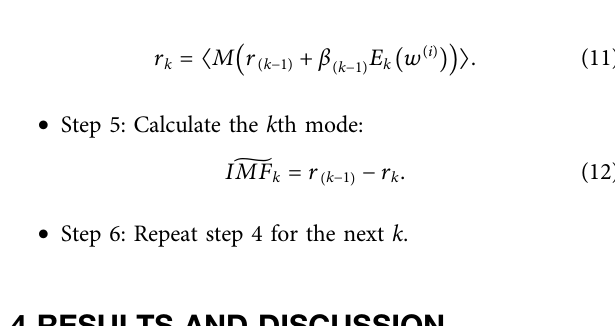
FIGURE 3 | Box-plot of daily PM 10 concentrations at Martinique (MAR), Guadeloupe (GPE) and Puerto-Rico (PR) from 2006 to 2016. The horizontal lines within the box represent the median while the bottom and top of each boxarethe25thand75thpercentiles.Thewhiskersarethe5thand95th